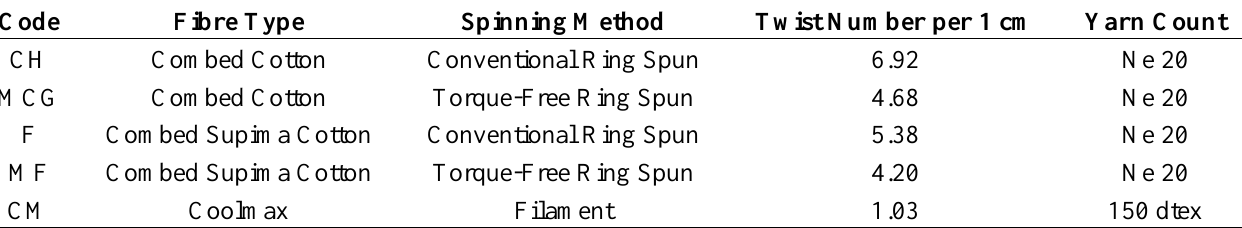
Table 1. Yarn specification.